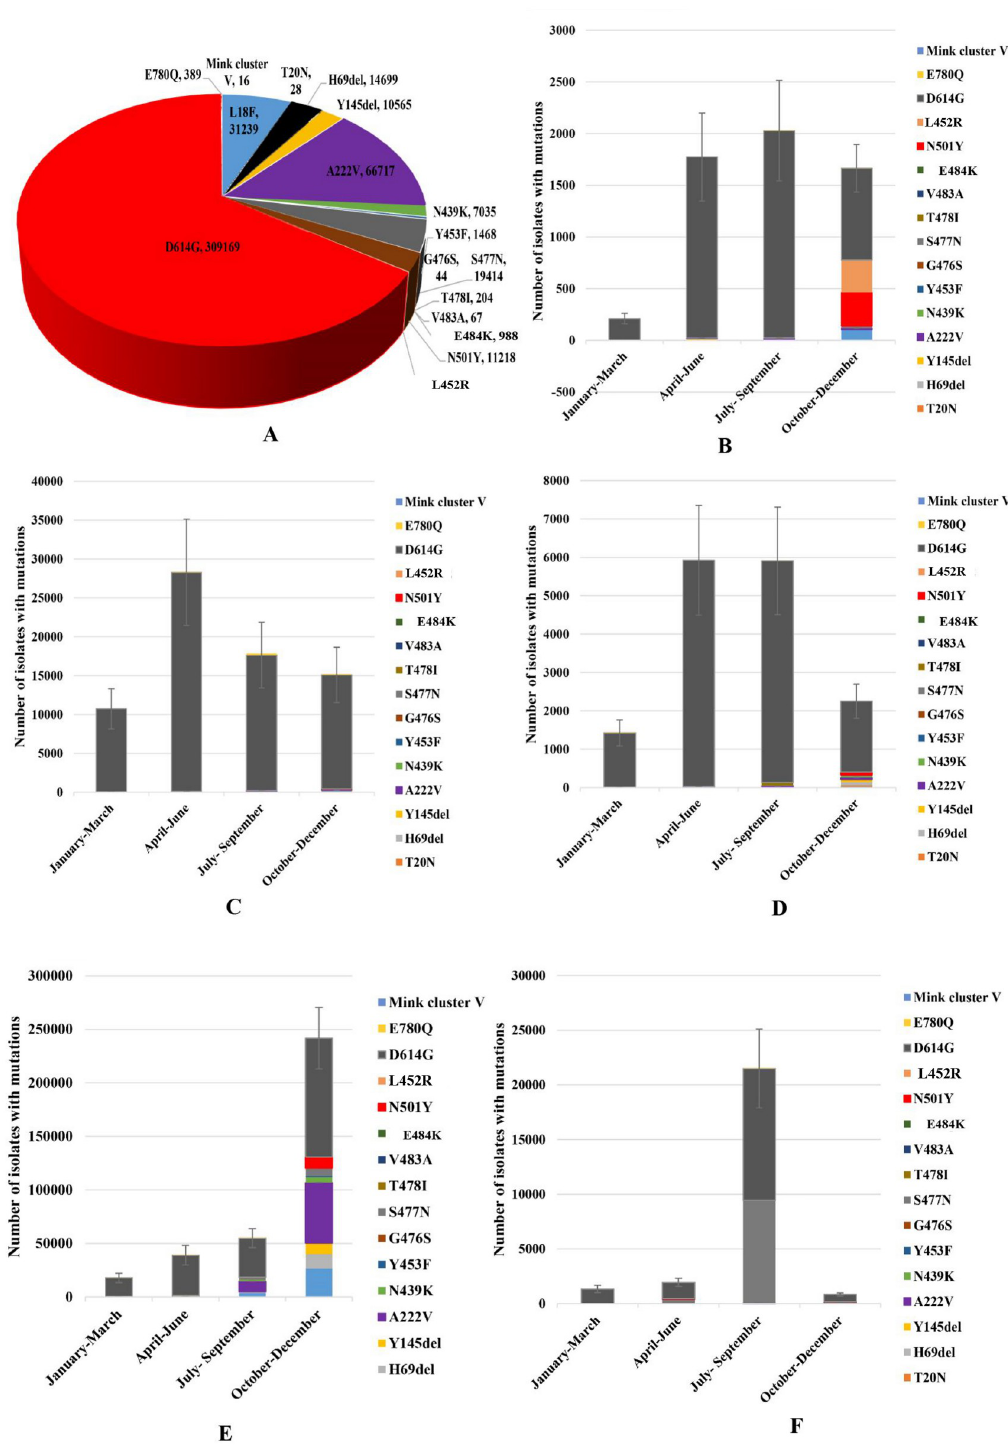
Fig 3. (A) Temporal and spatial distribution of substitution of frequency of point mutations at spike protein of SARS-CoV-2 worldwide during January, 2020 to December, 2020. (B-F) Continent-wise frequency distribution of the detected significant mutations at spike protein during January, 2020 to December, 2020 [(B) Africa, (C) America, (D) Asia, (E) Europe, and (F) Oceania, respectively]. Wuhan-Hu-1/2019 was used as reference sequence in this analysis.